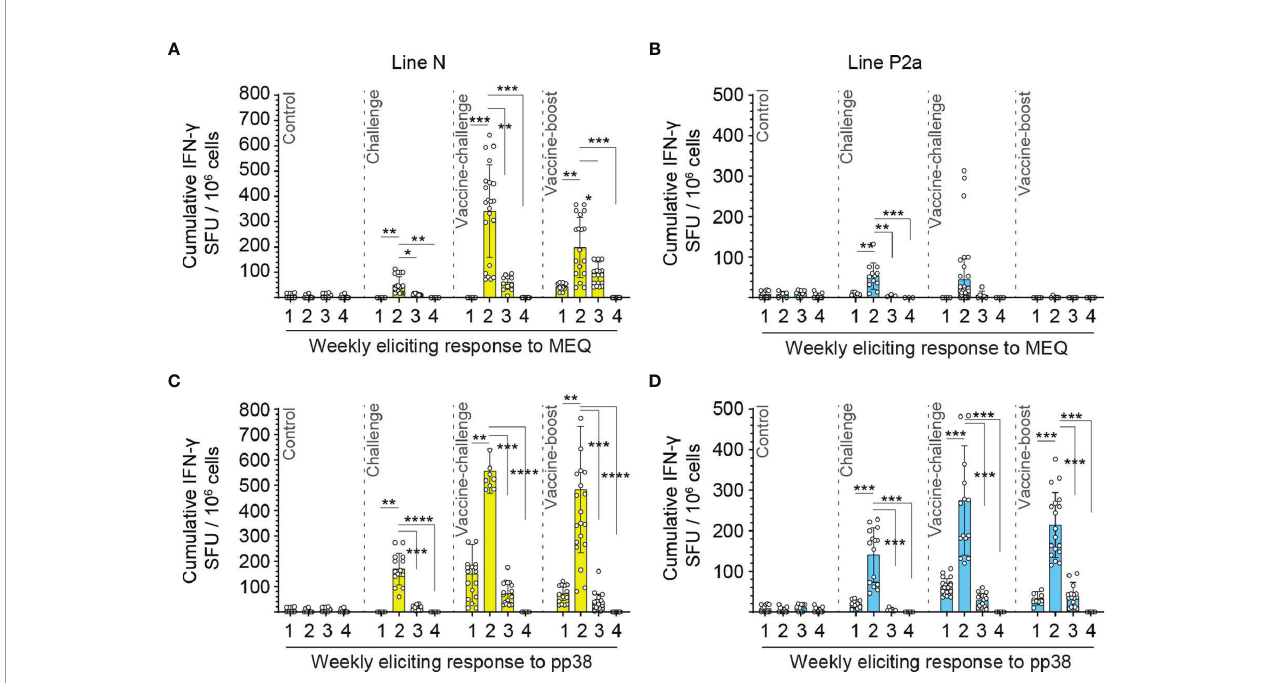
FIGURE 2 | MEQ and pp38 -speci fi c T cells are peaked at two weeks post inoculation in both line N and line P2a chickens. Mononuclear cells were isolated from spleens of the experimental groups at weeks 1, 2, 3, and 4 post last inoculation and the frequencies of antigen-speci fi c IFN-gamma producing T cells in response to MEQ or pp38 derived peptide pools were determine in line N (yellow bars) (A, C) and line P2a (blue bars) (B, D) chickens using an ex vivo chicken IFN-gamma ELISPOT assay. The frequencies of IFN-gamma producing cells are presented as SFU in 10 6 splenocytes (in triplicate for each bird) and shown as mean ± SD of each ELISPOT well. Splenocytes. Non-parametric Wilcoxon tests (Mann – Whitney) was used to assess normal distribution and test signi fi cance. * ( P ≤ 0.05), ** ( P ≤ 0.01), *** ( P ≤ 0.005) and **** ( P ≤ 0.001) indicates as statistically signi fi cant as corrected from the mock-infected control